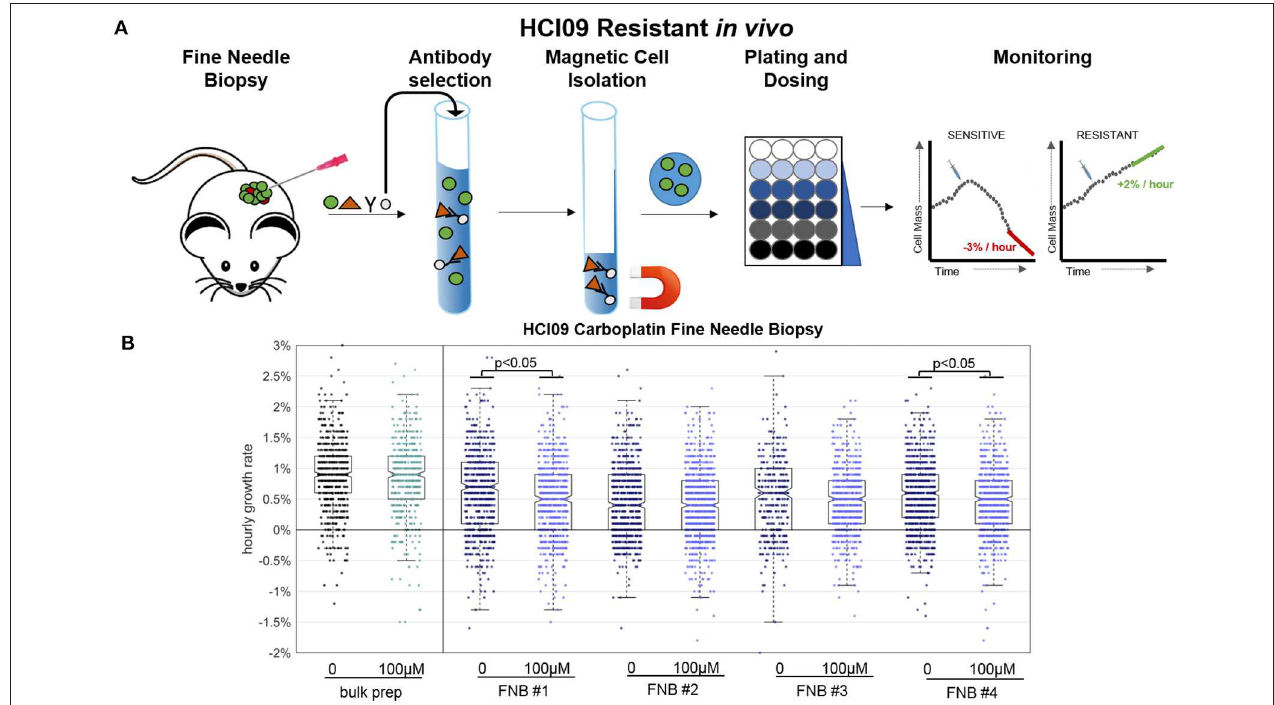
FIGURE 5 | Fine needle biopsy (FNB) sample preparation compared to bulk prep. (A) Timeline for key steps in the FNB. (B) HSLCI results for carboplatin-resistant PDX HCI09. Box plot notches are indicative of 95% confidence intervals for the medians, and each dot represents the growth rate of one